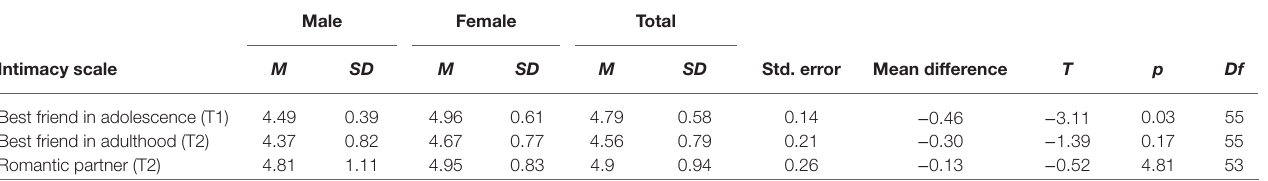
TABLE 4 | Averages of Intimate Friendship Scales in adolescence and in adulthood, comparison between men and women.